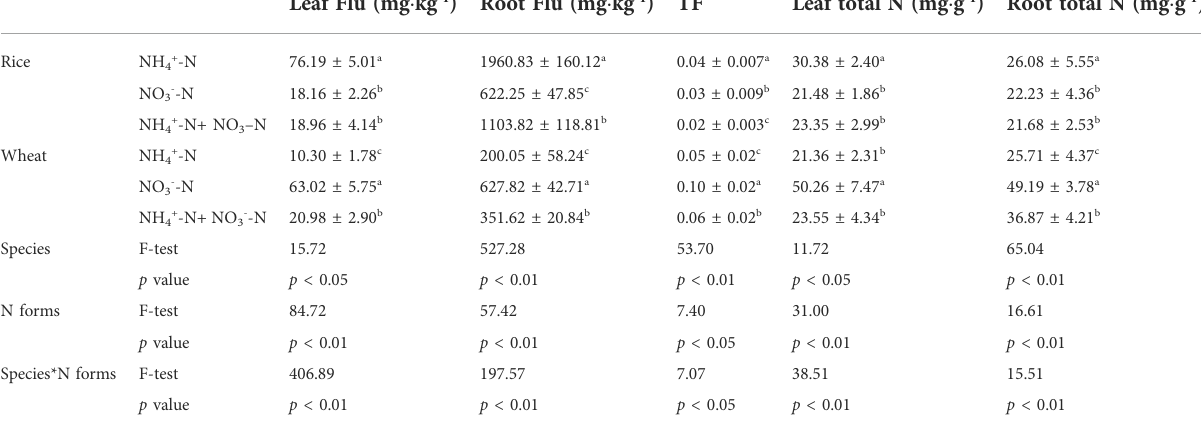
TABLE 1 The direct and indirect relationships between variables. The path coef fi cients are calculated by PLS-PM after 1,000